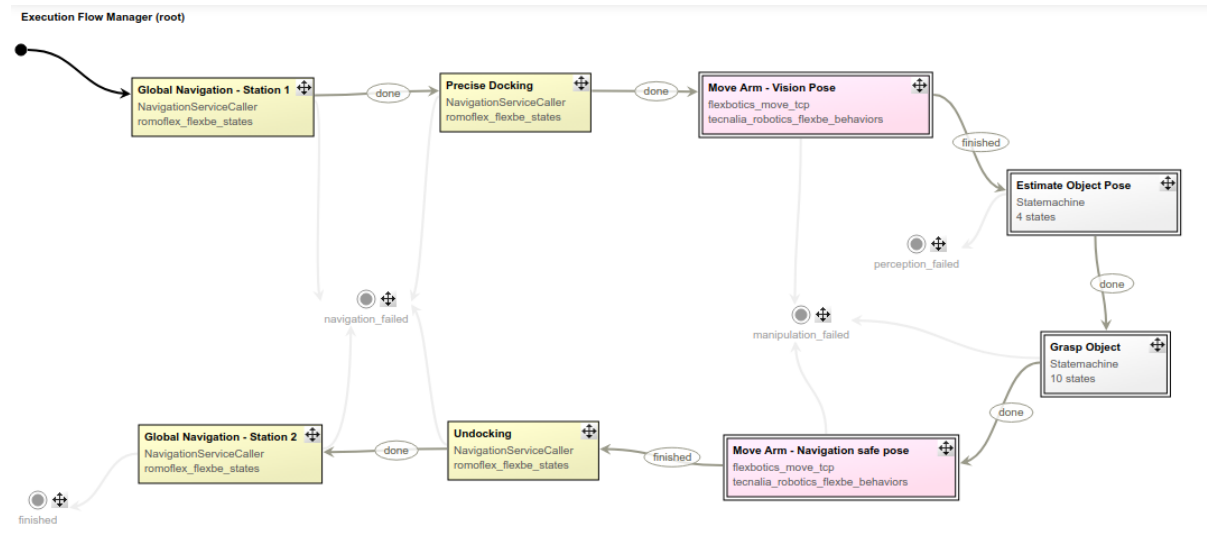
Figure 7. Developed skills sequenced in a Flexbe behavior.